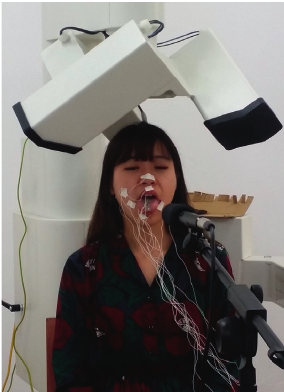
Figure 3: Acquisition diagram of bimodal signal. Table 1: Number of pieces of data in the database after selection. Emotion